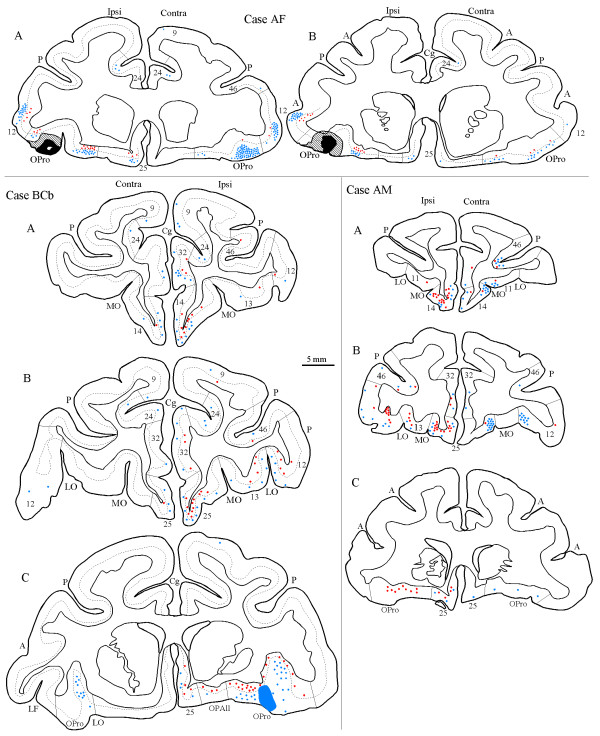
Bilateral distribution of projections neurons directed to orbitofrontal cortices. Coronal sections through the prefrontal cortex showing labeled neurons in ipsilateral (ipsi) and contralateral (contra) hemispheres after infection of tracers in three cases. Rostral to caudal sections are shown from left to right (case AF), and top to bottom (cases BCb and AM). (Top) The injection of HRP was in area OPro (A, B, black area) and labeled neurons are seen in layers II-III (blue dots) and layers V and VI (red dots); (Left) Injection of fast blue was in area OPro (C), blue area). (Right) Injection of HRP was in the rostral part of area 11 (not shown). Dotted lines through the cortex in the coronal sections show the bottom of layer IV. Architectonic areas indicated by letters include: OPAll, orbital periallocortex; OPro, orbital proisocortex. Other architectonic areas are indicated by numbers. Abbreviations: A, arcuate sulcus; Cg, cingulate sulcus; LF, lateral fissure; LO, lateral orbital sulcus; MO, medial orbital sulcus; P, principal sulcus.